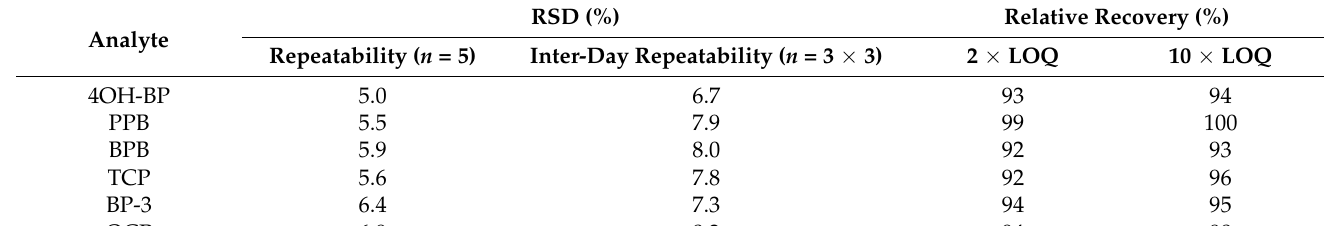
Table 2. Relative standard deviations and relative recoveries of the examined analytes from lake water.